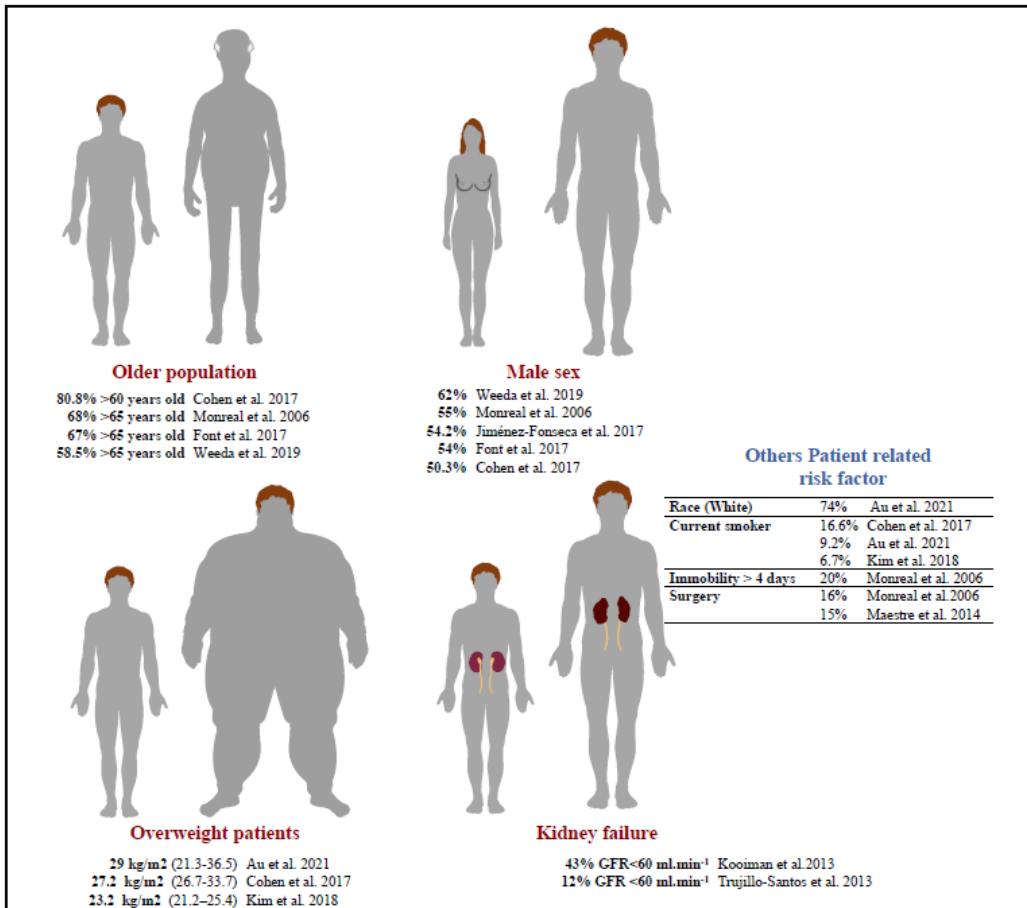
Figure 1. Patient-related risk factors for cancer-associated PE [4–6,9–15].